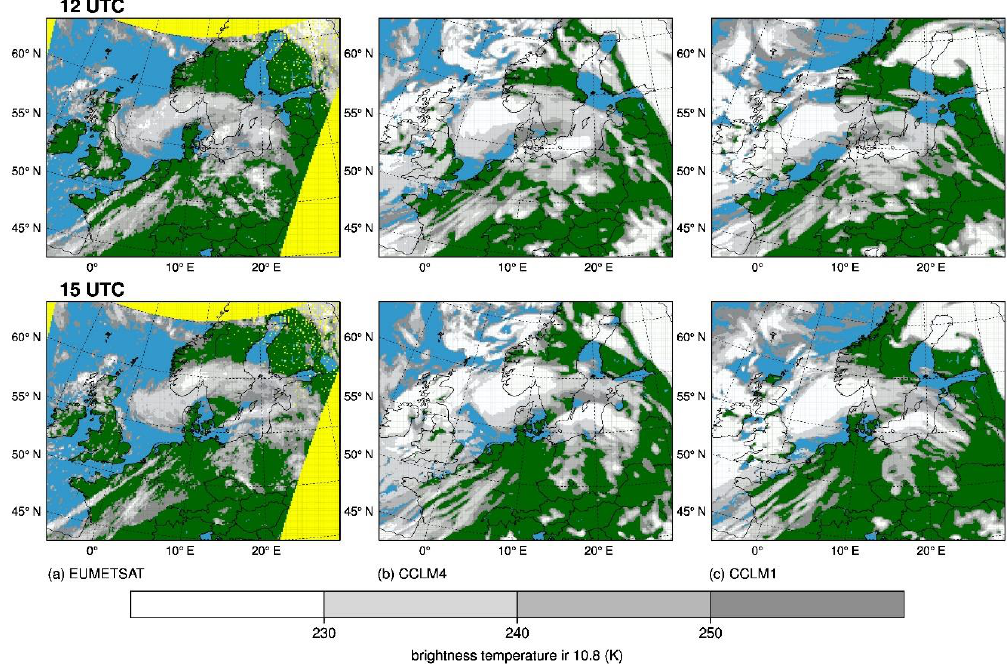
Figure 16. Synthetic satellite image at the wavelength of 10.8 µm of ( a ) EUMETSAT, ( b ) CCLM4, and ( c ) CCLM1. Brightness temperature over 260 K is transparently plotted. Blue and dark green colors indicate ocean and land areas, respectively. Yellow color indicates missing values. Time: 12 UTC (top panel) and 15 UTC (bottom panel) on 28 October 2013.